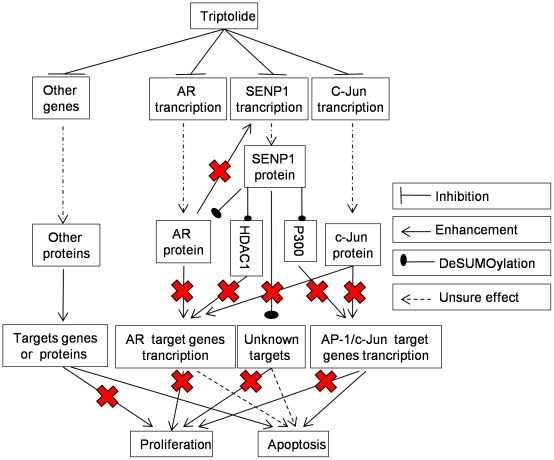
Hypothetic mechanisms of anti-PCa effects of Triptolide.Triptolide suppresses SENP1, AR and c-Jun expression, induces restoration of SUMOylation/deSUMOyaltion balance, inhibitions of the AR and c-Jun mediated transcription, which may all contribute to the anti-PCa effect of Triptolide. Other genes or proteins may involve in mechanism of Triptolide effect (see Discussion for detail).